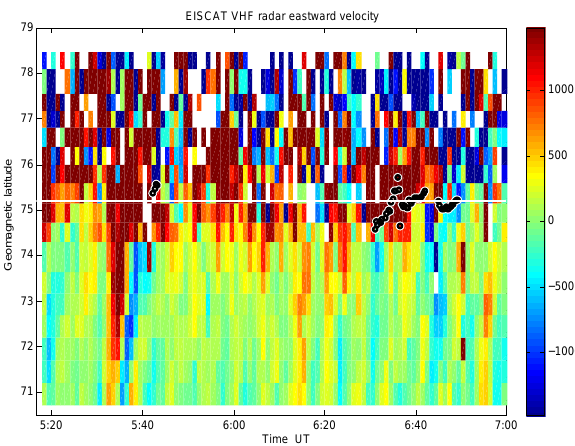
Fig. 1. East-west flow estimated from beam-swing analysis of the EISCAT CP4 split beam data [ ms − 1 ] (see text for details). Circles indicate latitude of the arcs discussed in the paper. The horizontal white line indicates the latitude of the EISCAT Svalbard